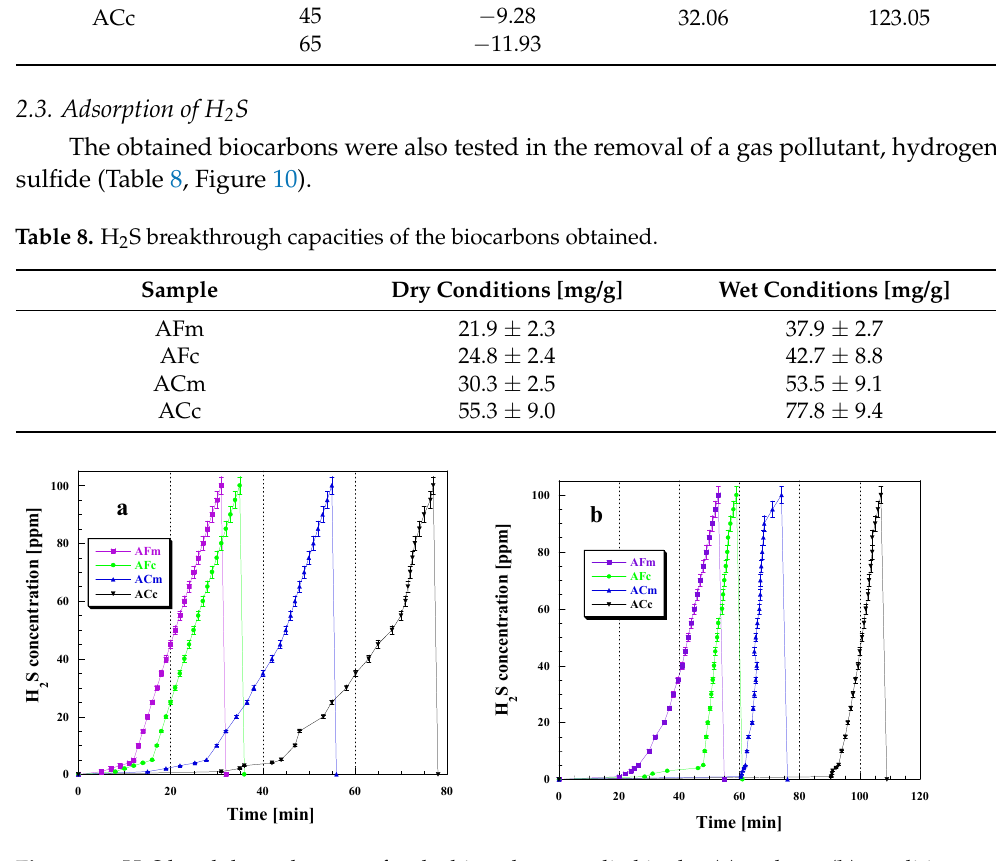
Figure 10. H 2 S breakthrough curves for the biocarbons studied in dry ( a ) and wet ( b ) conditions.